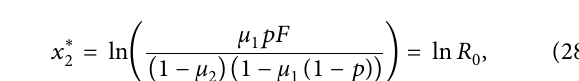
Figure 5: Model (1) trapping region ( μ Shaded part is the 6-cyclic attractor, while the fxed point is